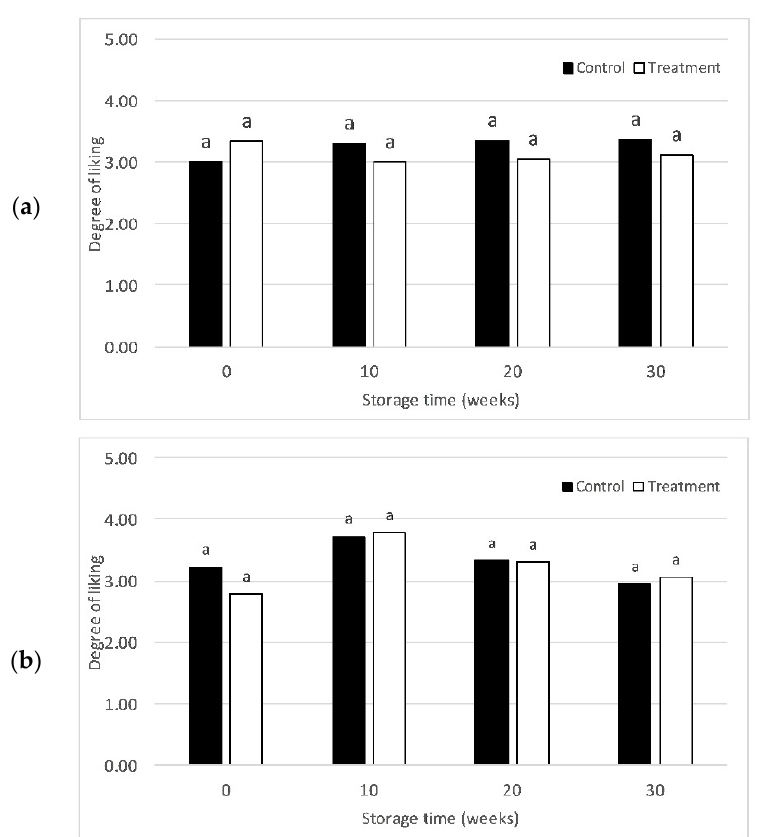
Figure 2. Effect of summer pruning on degree of liking of ‘Reinette du Canada’ apple fruit grown in two locations, ‘Cabañas’ ( a ) and ‘Almázcara’ ( b ). Bars represent mean values and different letters above bars indicate significant differences according to LSD test ( p < 0.05).